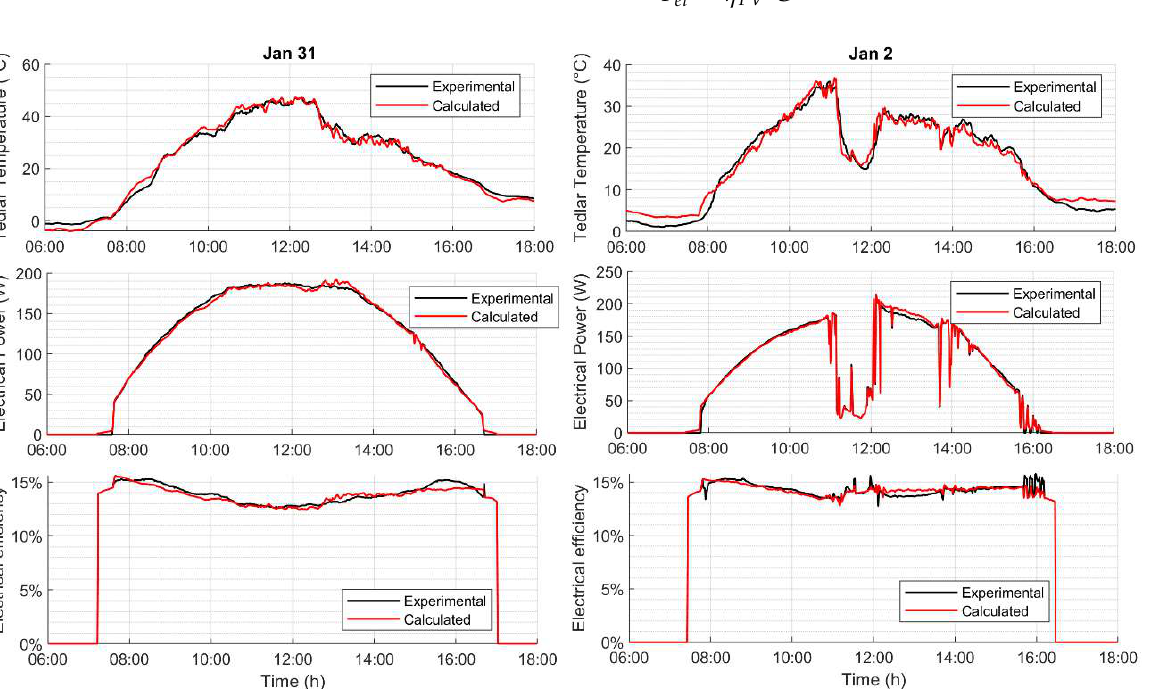
Figure 7. Tedlar Temperature, Electrical Power and Efficiency for a clear day and overcast day.